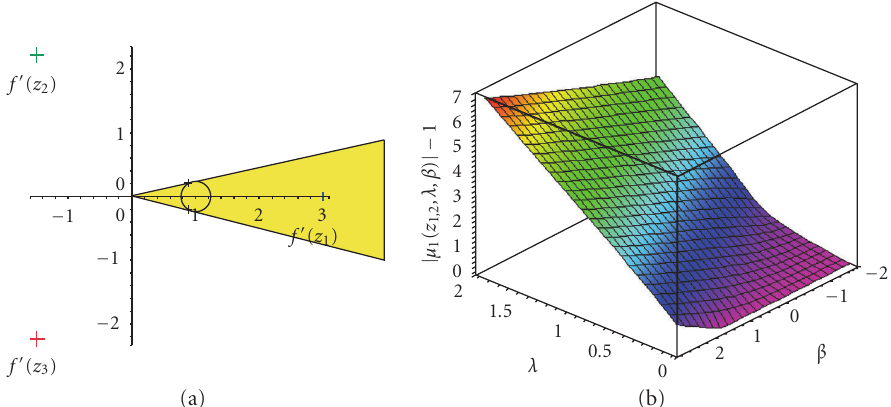
Figure 4.5. (a) The cone (cid:4) z . (b) Function graph ( λ , β ) → | μ 1 ( z i , λ , β ) |− 1 ( i = 1,2). I , z S